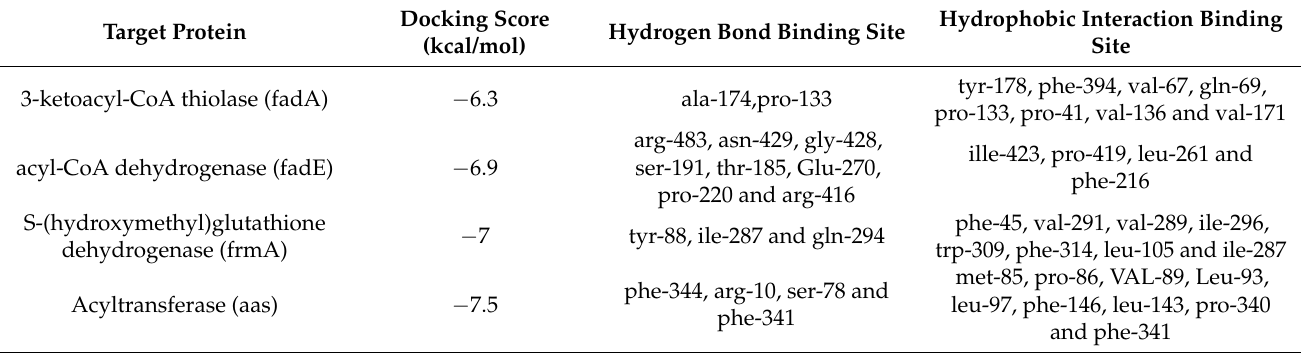
Table 1. Docking binding energy between BCp12 and target protein.